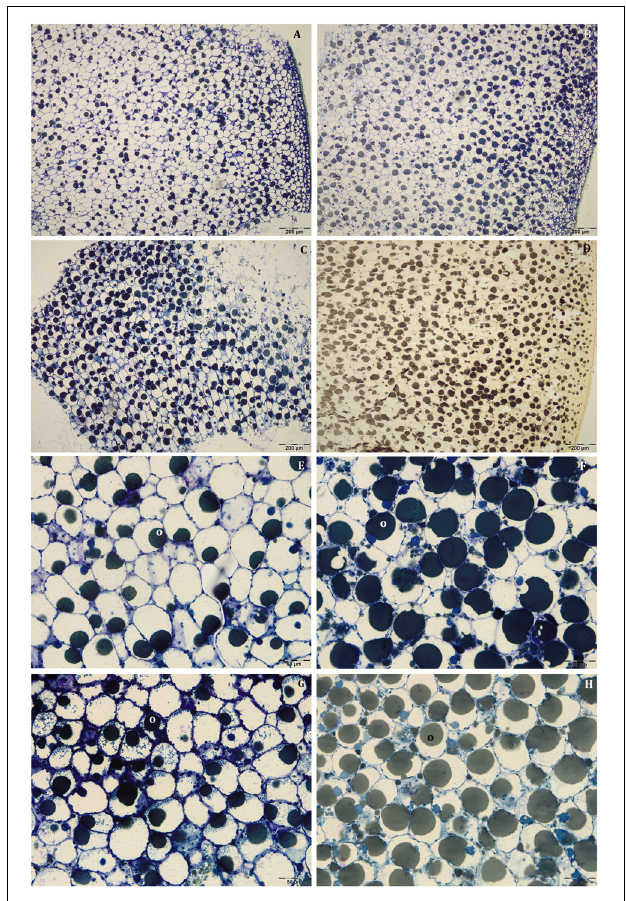
Light fruits were taken on the external portion of the canopy, while shade fruits were collected in the centre. Different letters indicate statistically significant differences by T-test at p ≤